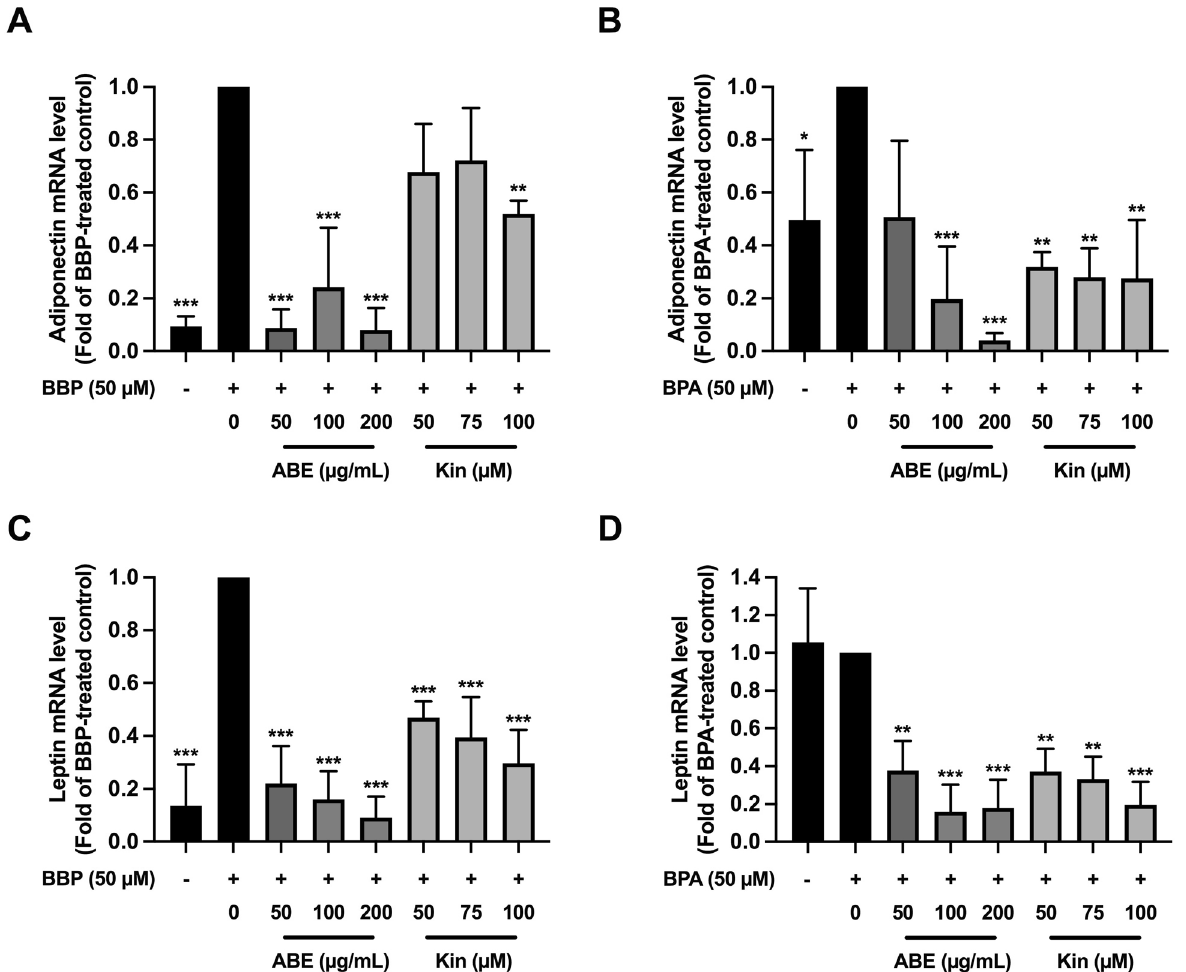
Figure 4. The effect of ABE or Kin on obesogen-induced adipokine gene expression in 3T3-L1 cells determined by RT-qPCR. Adiponectin mRNA level in BBP- ( A ) and BPA- ( B ) treated cells in the presence of ABE or Kin. Leptin mRNA level-induced in BBP- ( A ) and BPA- ( B ) treated cells in the presence of ABE or Kin. The data indicated as mean ± SD of three independent experiments * p < 0.05, ** p < 0.01 and *** p < 0.001, compared to obesogen-treated